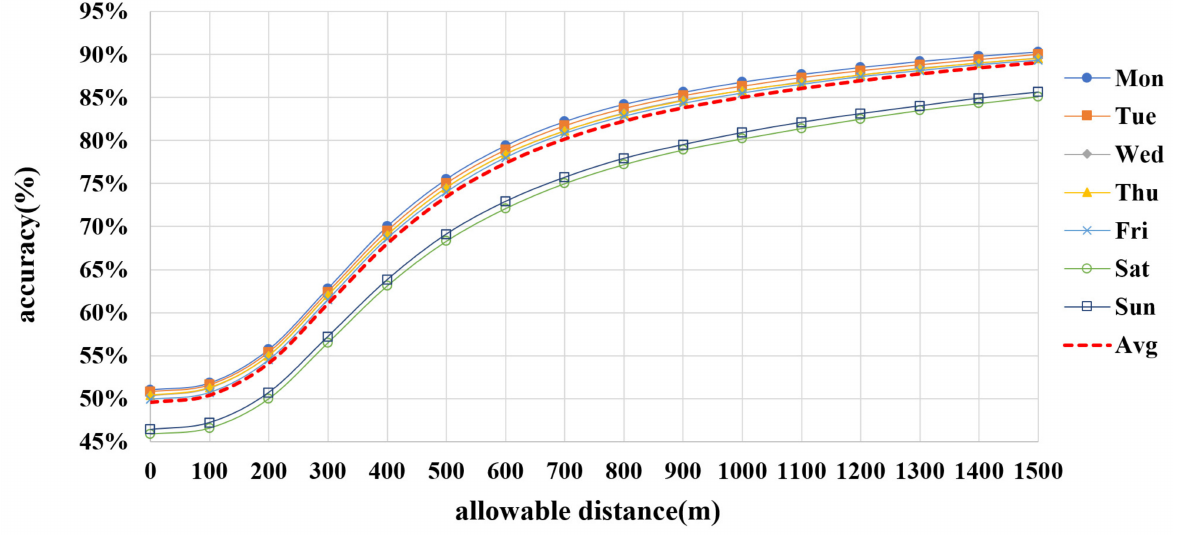
Figure 4. Result of destination estimation